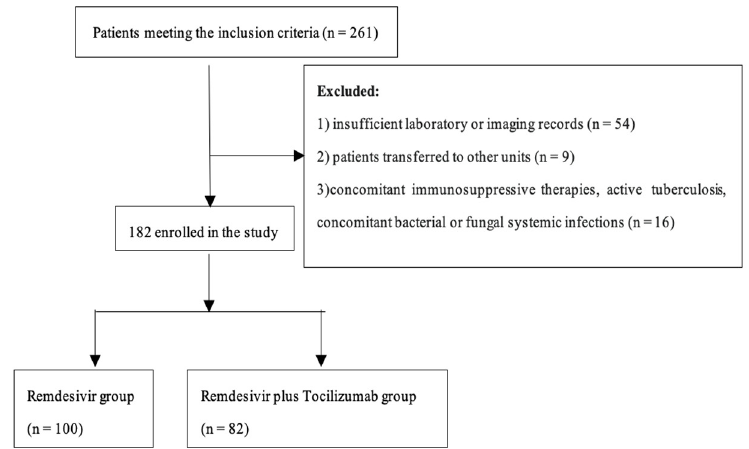
Figure 3. Study flowchart.